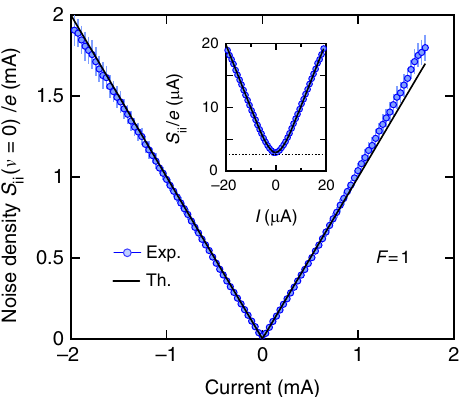
Fig. 4 Electronic shot noise of the tunnel junction. Measurements done in the bandwidth 20 – 100 kHz. The Fano factor F = 1 characterizes the tunneling regime. The error bars are SD. Inset: Zoom at low bias voltage. Solid lines correspond to the theoretical expectation of Eq. (6) with T